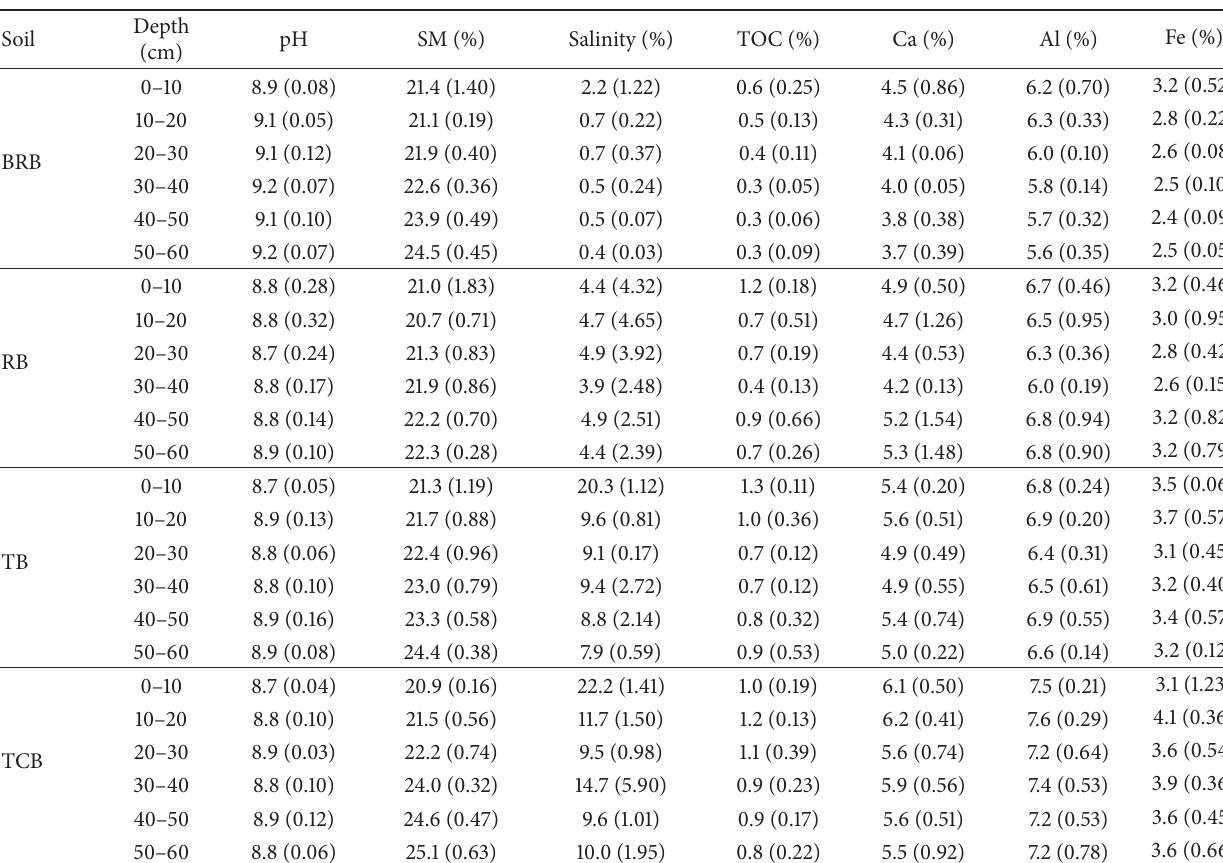
Table 1: General characteristics of the soils in the tidal river network region.